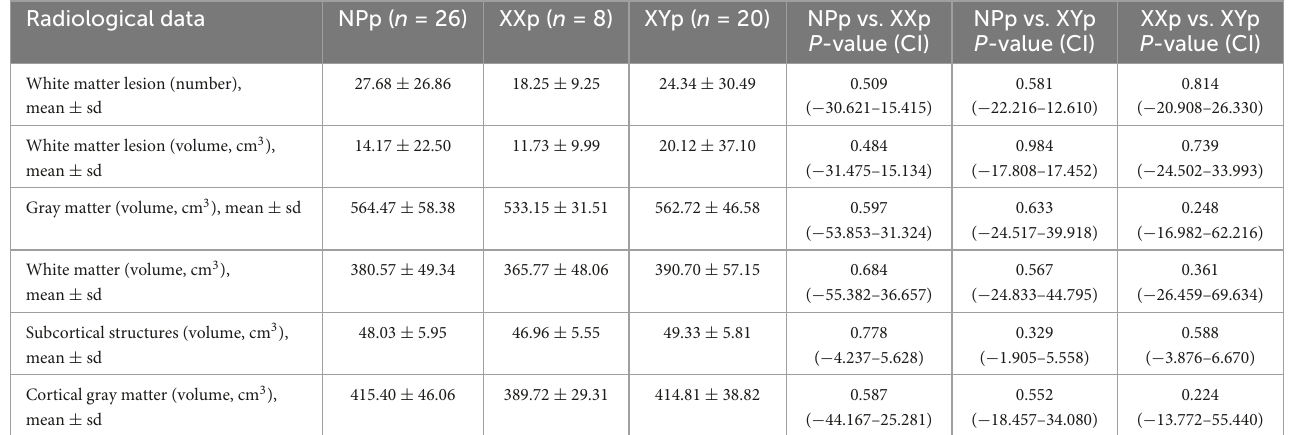
TABLE 5 Radiological data for whole-brain